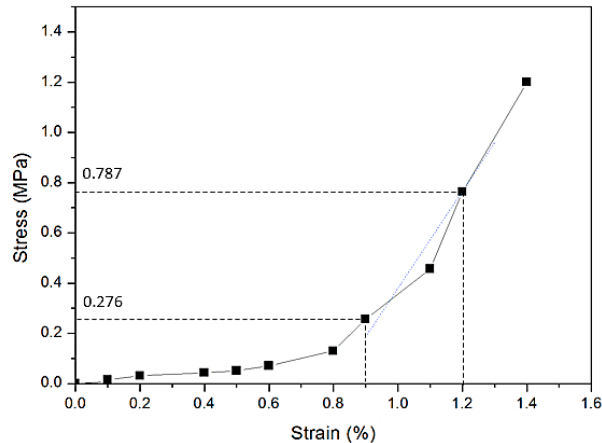
Figure 8. Initial part of the circumferential tensile stress-strain curve of the PET tubular graft that contains the stress range corresponding to compliance test pressures and the fitting line of these compliance test pressure ranges.